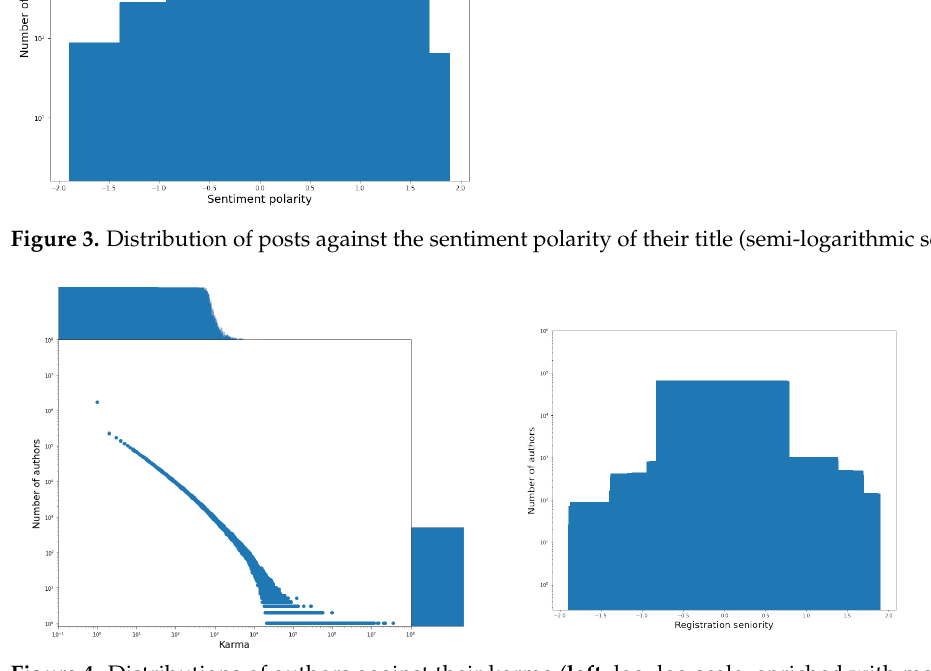
Figure 4. Distributions of authors against their karma ( left , log–log scale, enriched with marginal distributions) and registration dates ( right , semi-logarithmic scale).